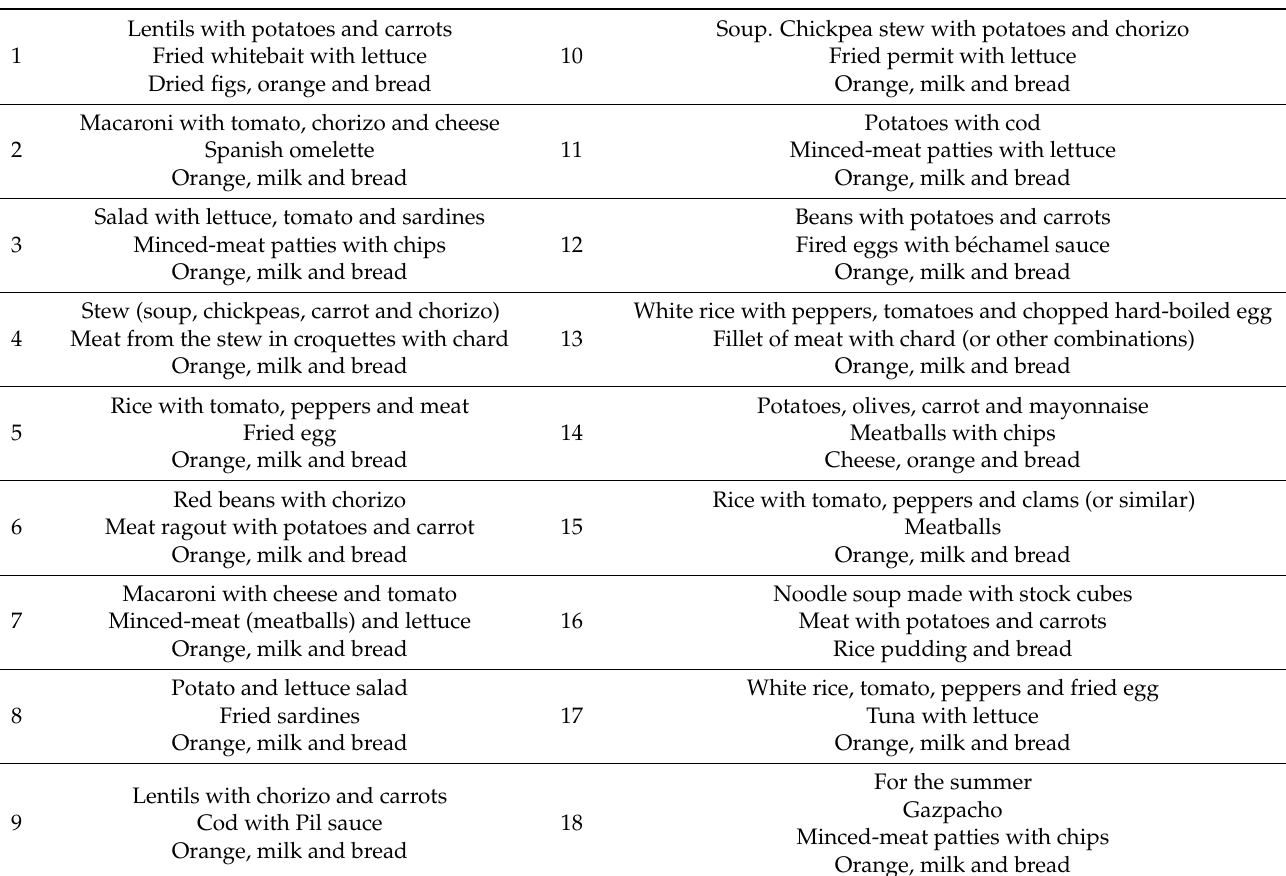
Table 1. School lunches (first and second course, dessert, dairy complement or dried fruit and bread) elaborated in